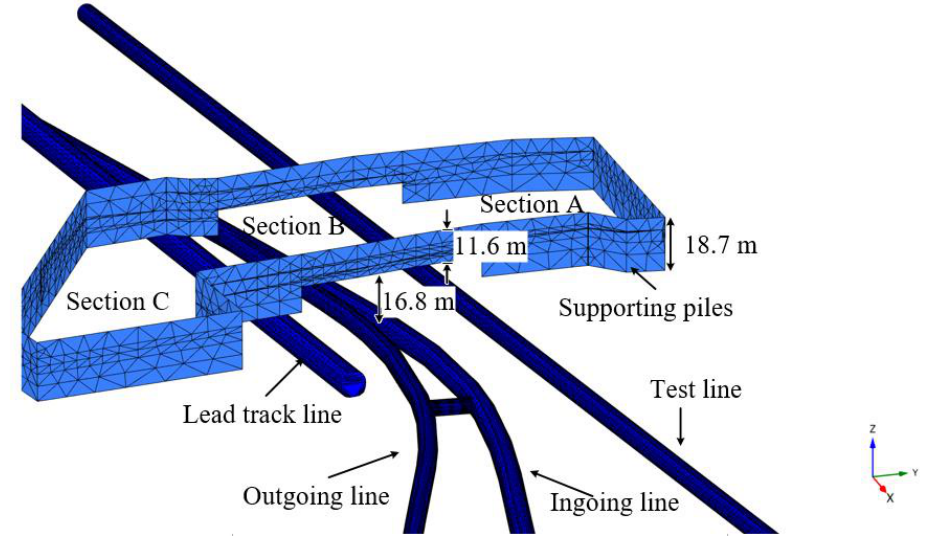
Figure 5. Mesh of tunnels and support piles.